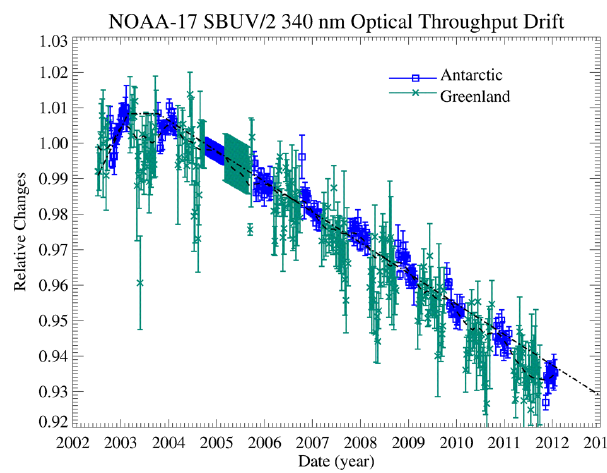
Fig. 3. Region of Antarctica used for SBUV/2 snow/ice albedo cal- ibration measurements (dark outline). The size of a typical SBUV/2 field of view is shown by the filled square.